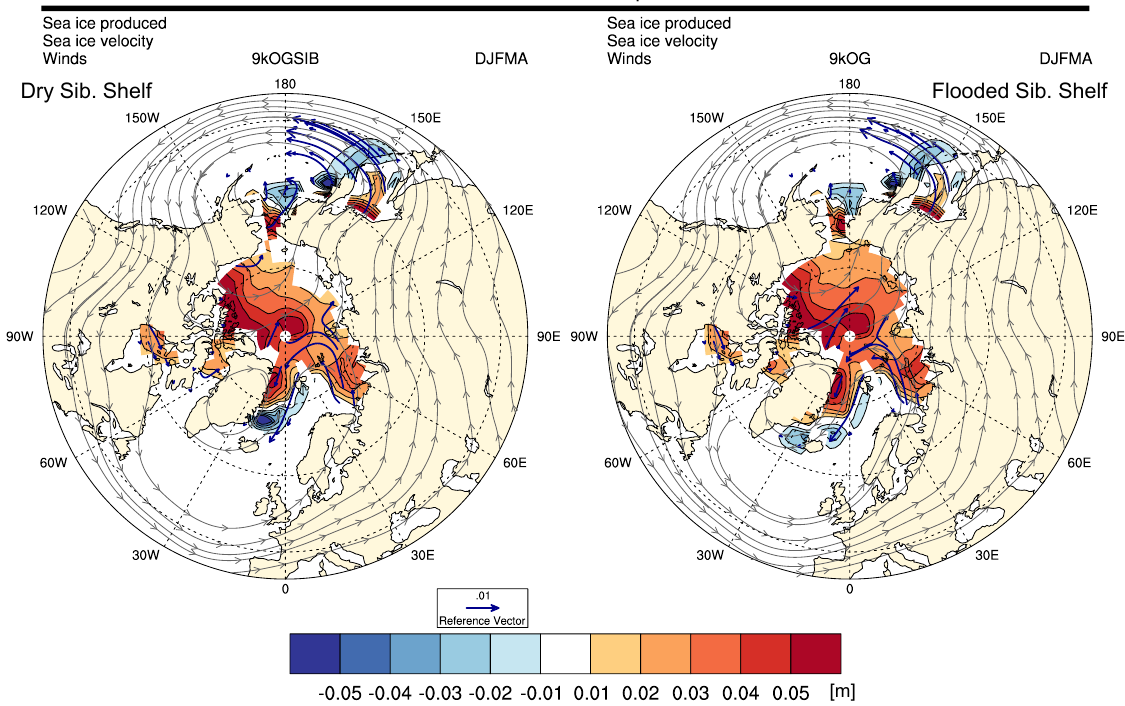
Fig. 8. Winter (December to April) cumulative sea-ice production (in m, colour shaded), sea-ice velocity (in ms − 1 ) as curly vectors (blue) and atmospheric winds (in ms − 1 ) as streamlines (grey). Left panel shows the dry Siberian shelf simulation 9kOGSIB. Right panel shows the flooded Siberian shelf simulation 9kOG.